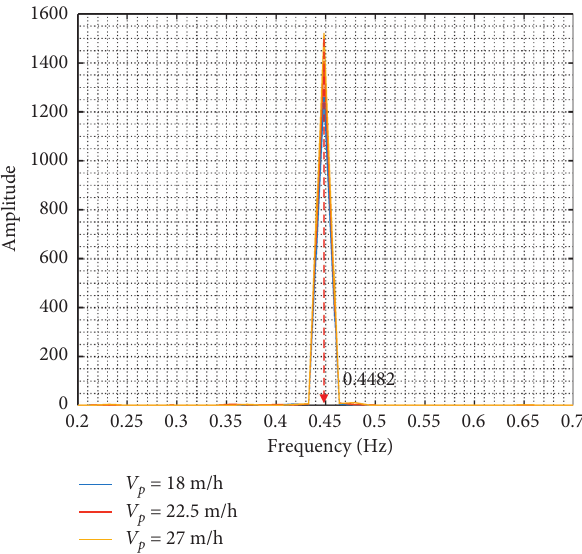
Figure 9: Variation of the maximum amplitude of torque fluc- tuation changing with penetration rate.